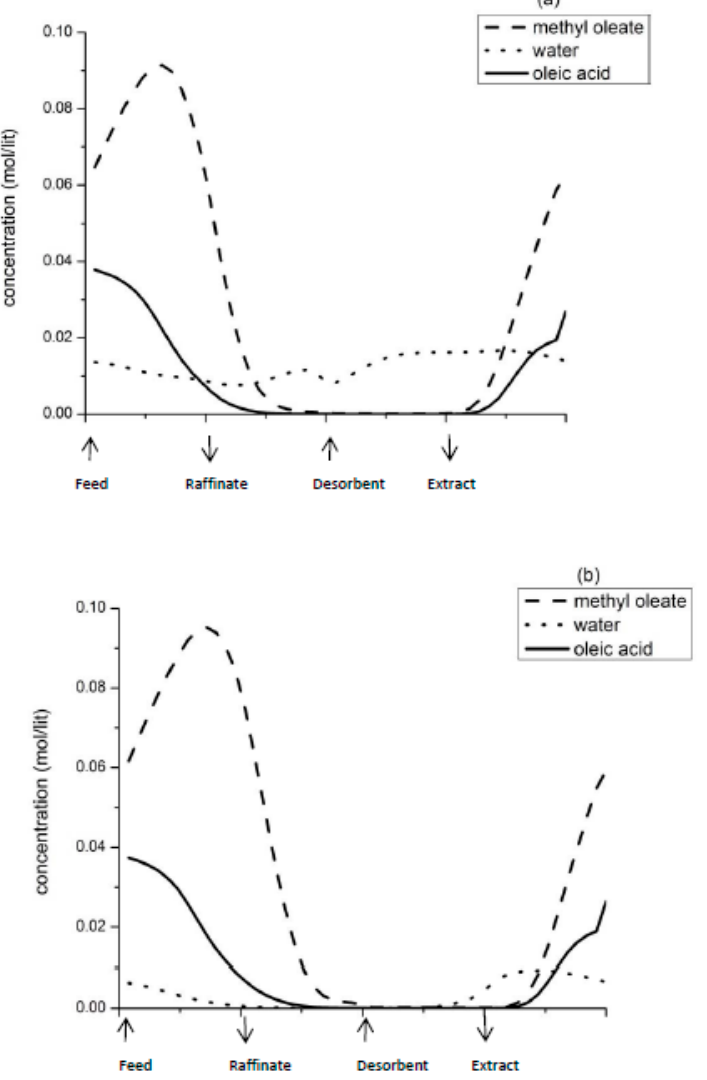
Figure 3. Steady state concentration profiles of methyl oleate-water-olenic acid system; ( a ) corre- sponding to point 1 & ( b ) corresponding to point 2 of Figure 2.